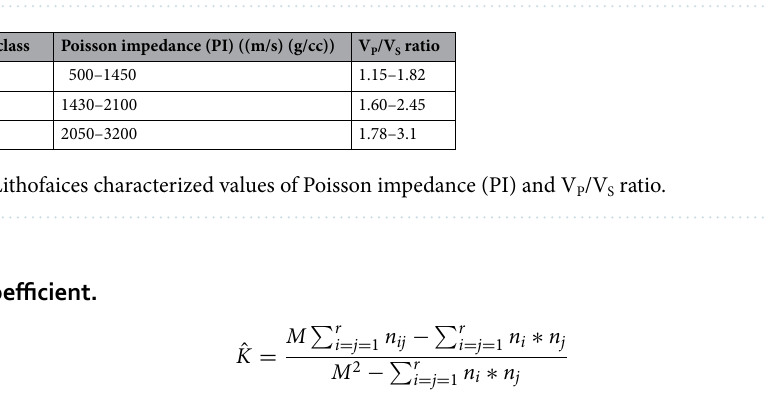
Figure 6. Lithofacies classification procedure and quality measures: ( a ) cross-plot analysis between PI and V P / V S ratio; ( b ) non-parametric PDFs; ( c ) confusion matrix; ( d ) visual inspection of predicted lithofacies at wells (Well#A and Well#C).